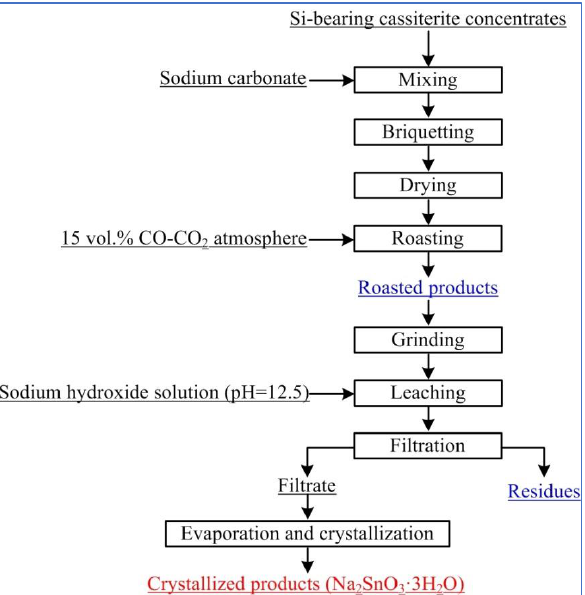
Figure 2. The flowsheet for preparing sodium stannate from Si-bearing cassiterite concentrates.